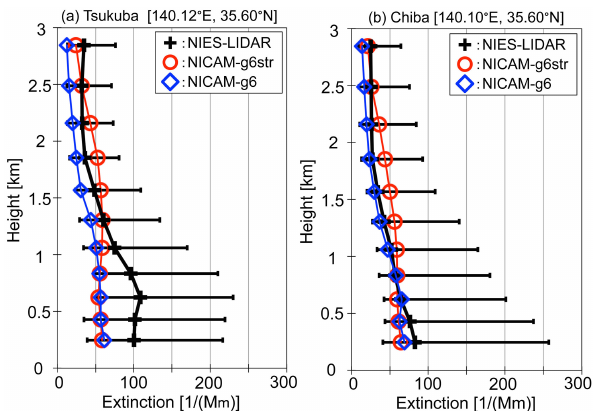
Figure 18. Extinction coefficients in August averages for the spher- ical particles simulated by NICAM-g6str and NICAM-g6 and the spherical particles observed by the NIES-LIDAR network at (a) Tsukuba and (b) Chiba, in units of 1 ( Mm ) − 1 . The bars rep- resent the 25th and 75th percentiles of the LIDAR